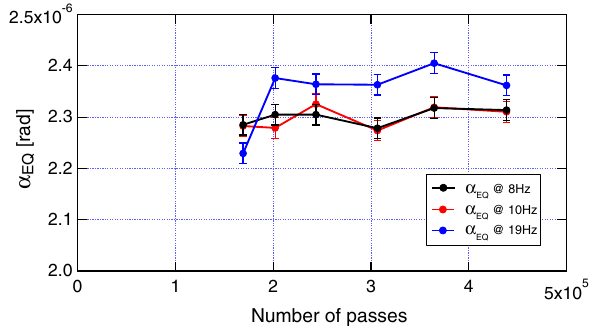
Fig. 7 Determination of α EQ as a function of N for both the Cotton- Mouton signals at 2 ν α,β and for the Faraday rotation at ν F